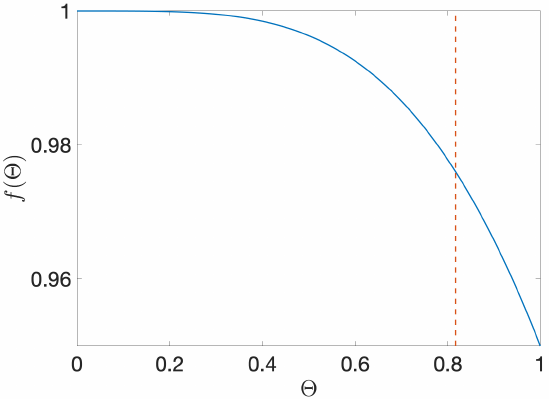
Figure 3. Unitarity of the matrix B for any value of the phase φ . The dashed vertical line shows the value Θ = 0.8169, which, together with φ = π , corresponds to the experimental setup for the realization of the Hadamard gate on such a